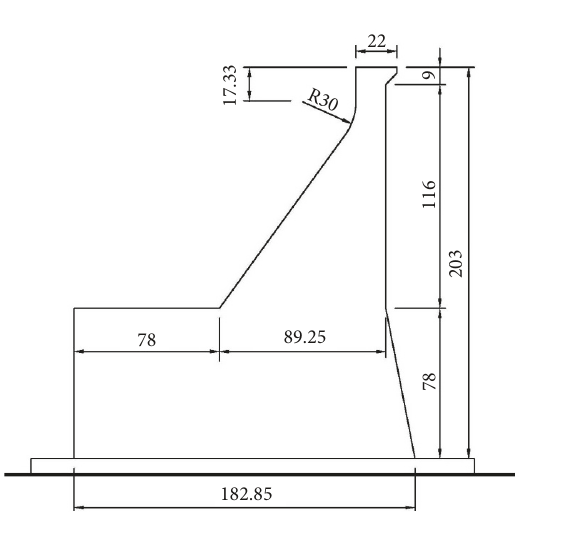
Figure 1: Scaled model dam of the concrete gravity dam (unit: